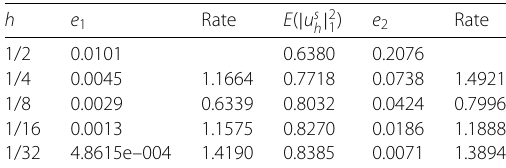
Table 13 The linear FVM for problem (5.3) with k = 1 h e 1